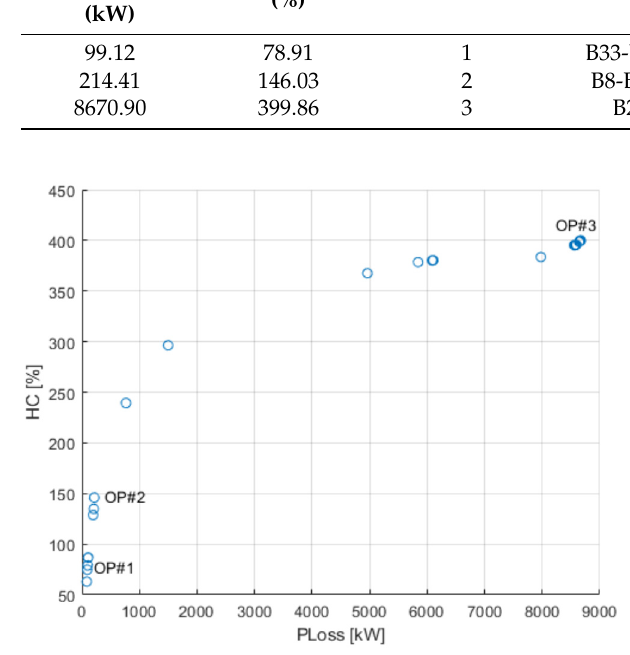
Figure 15. Pareto front for comparison with [12].